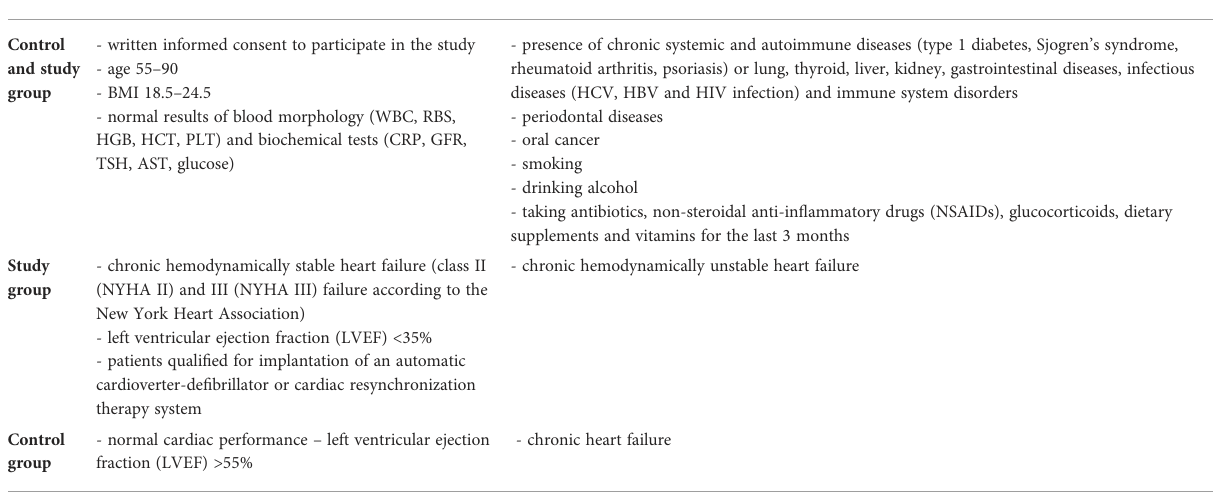
TABLE 1 Inclusion and exclusion criteria of HF patients and the control